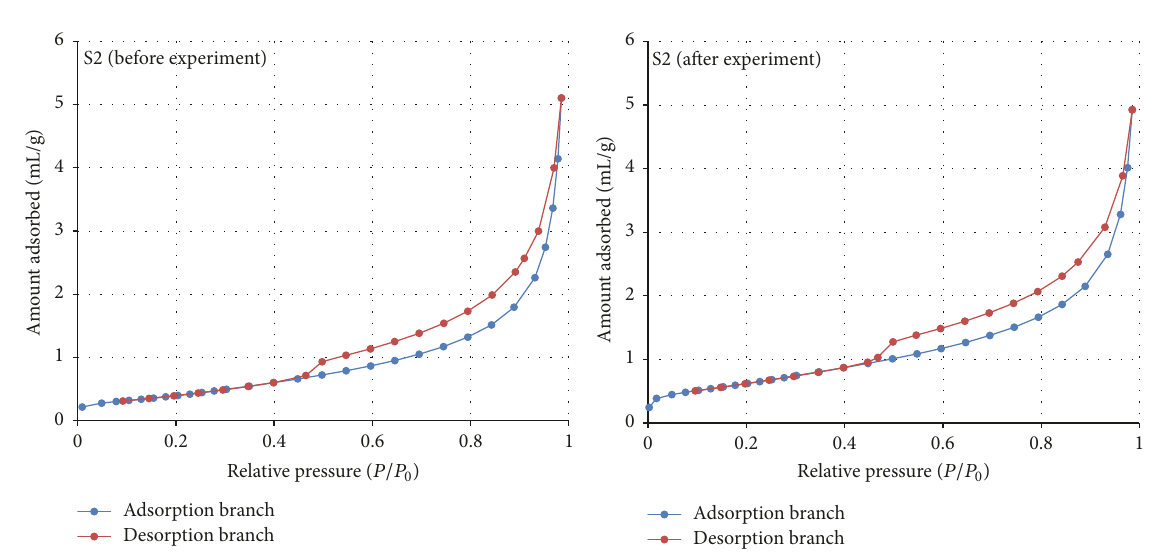
Figure 12: N 2 adsorption-desorption isotherms of